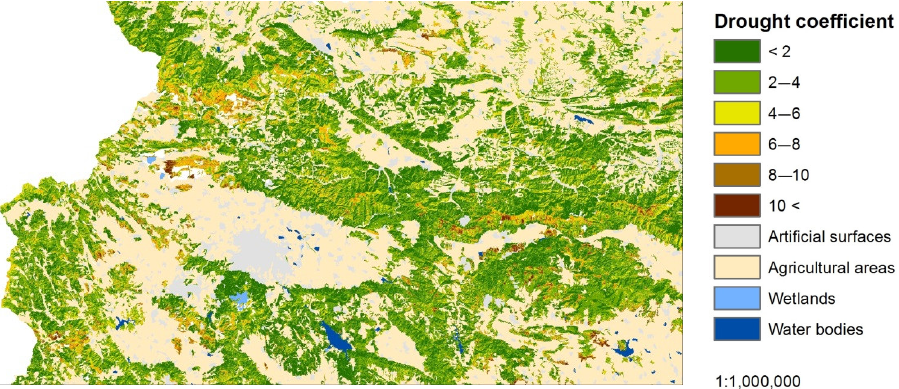
Figure 10. Distribution of the Drought coefficient (DC) at the end of August/beginning of Septem- ber 2020.